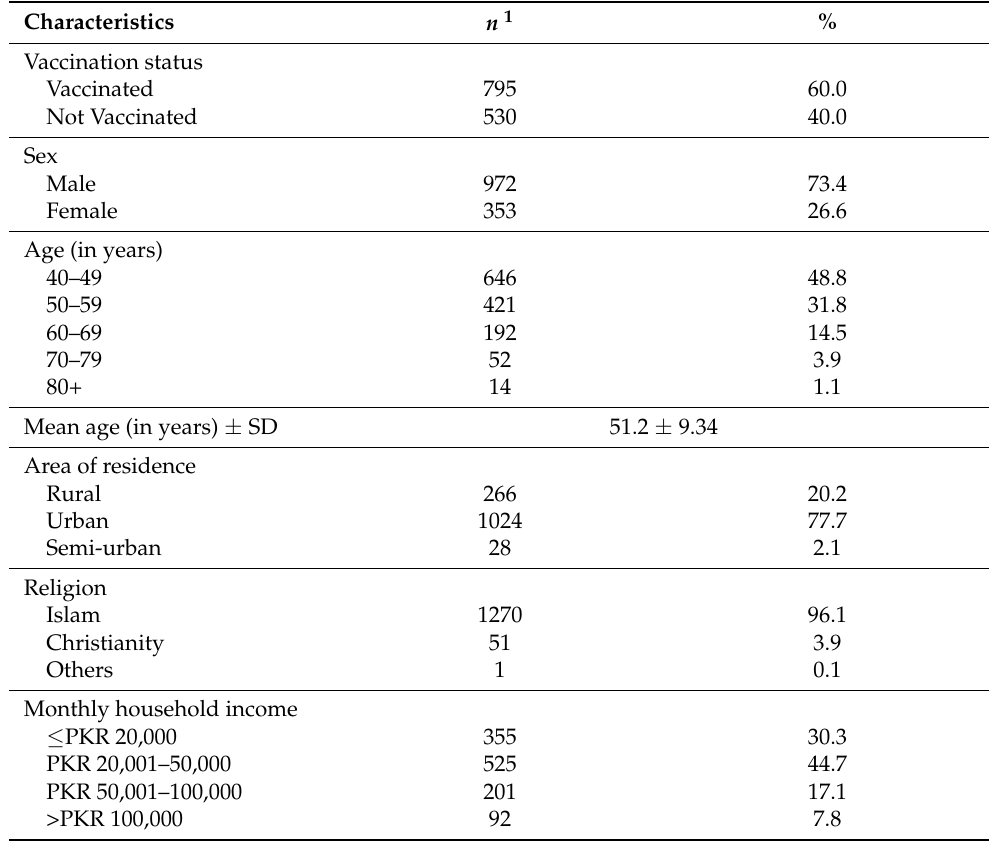
Table 1. Characteristics of study